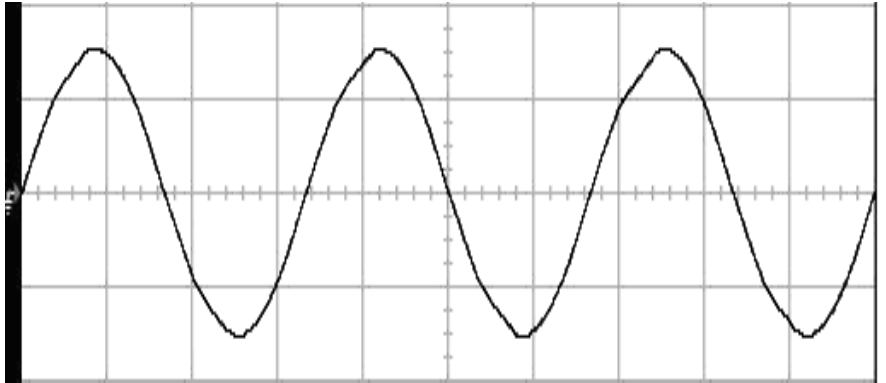
Figure 14. Experimental output voltage with the proposed controller at nonlinear load (vertical: 100 V/div; horizontal: 5 ms/div).